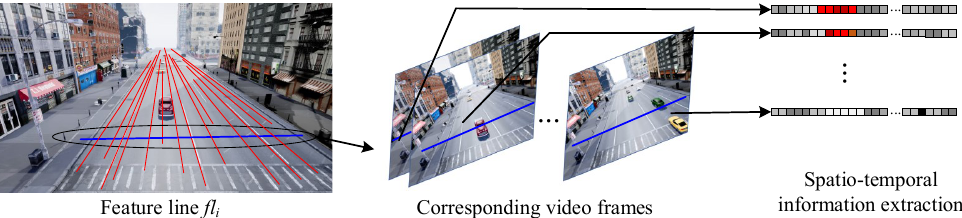
Figure 4. Spatiotemporal information extraction. With the position and direction of a sample feature line (circled on the left), we can extract the visual data at this location from each corresponding video frame. The related visual data are integrated into several rows in order on the right and form the spatiotemporal